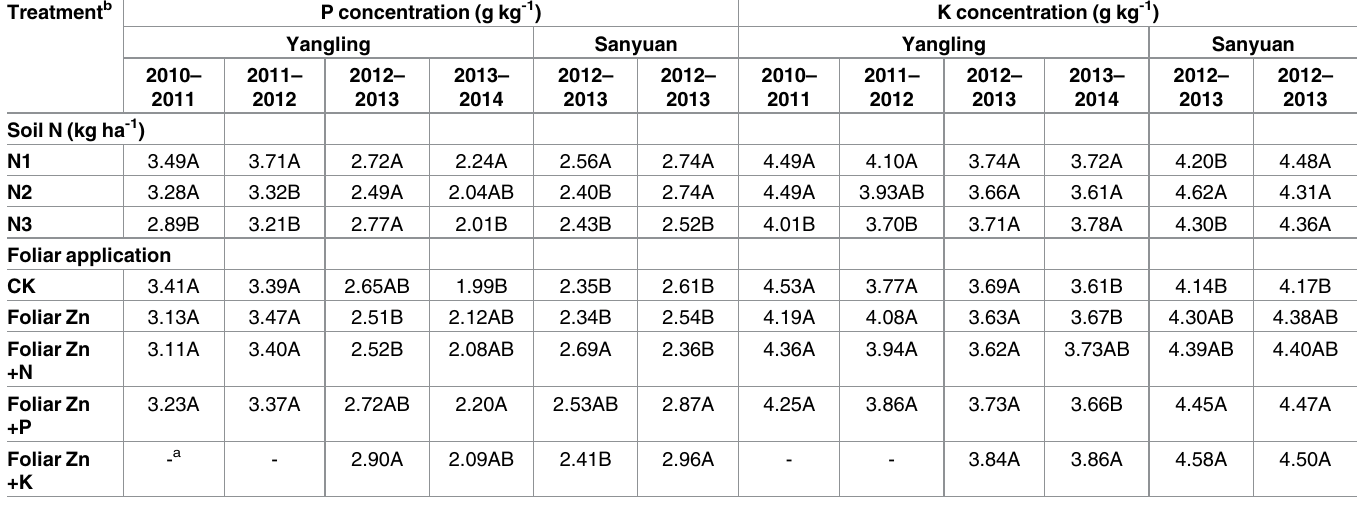
Table 5. Grain P and K concentration of winter wheat as influenced by soil N fertilizer rate and foliar fertilizer applications under field conditions at Yangling during 2010–2014and Sanyuan during 2012–2014. Treatment b P concentration (g kg -1